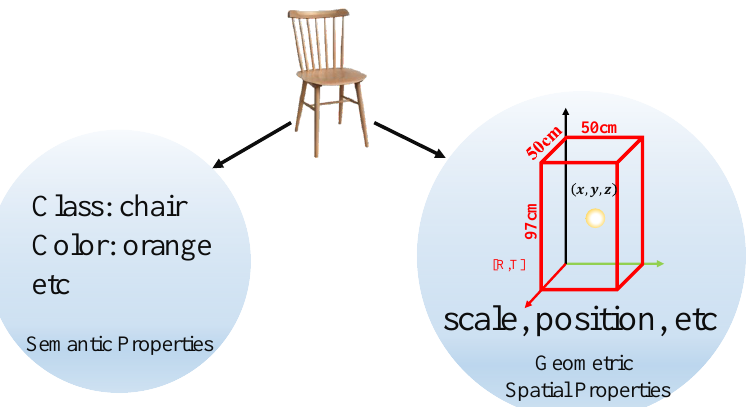
Figure 5. Schematic representation of the high-dimensional semantic–geometric features of the object. High-dimensional semantic-geometric features consist of semantic features (class, color, etc.) and geometric spatial features (scale, position,